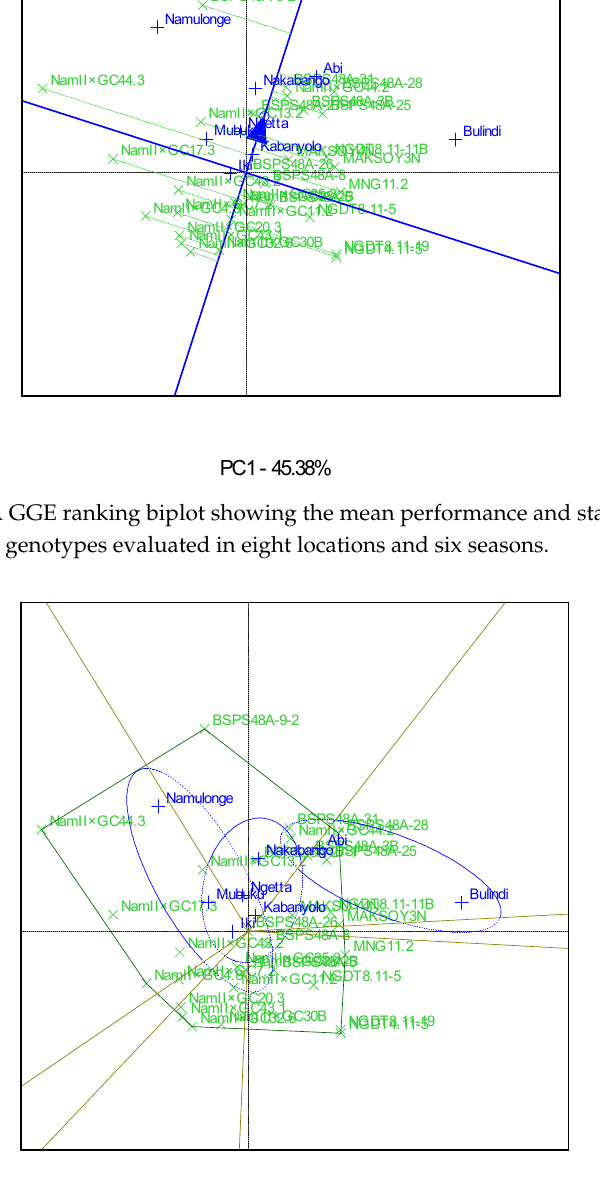
Figure 6. A GGE ranking biplot showing the mean performance and stability for the seed yields of 30 soybean genotypes evaluated in eight locations and six seasons .